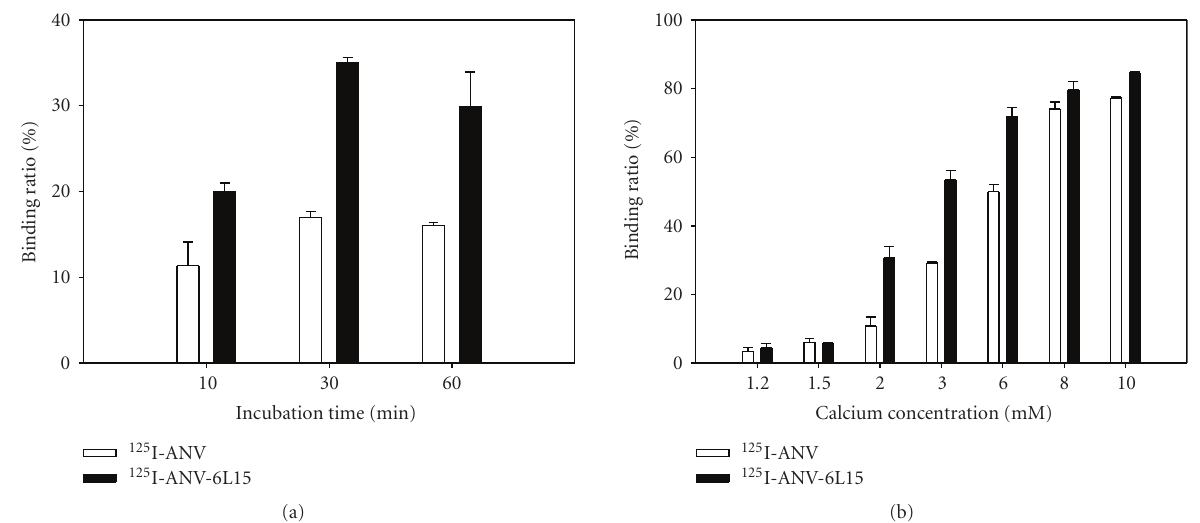
Figure 2: Binding of 125 I-ANV and 125 I-ANV-6L15 to erythrocyte ghosts. (a) Time course of binding of 125 I-ANV or 125 I-ANV-6L15 to ghost erythrocytes in the presence of 2.5 mM Ca 2+ at room temperature. (b) Binding of 125 I-ANV or 125 I-ANV-6L15 to ghost erythrocytes under various concentrations of Ca 2+ . Data are expressed as mean ± SD of three independent